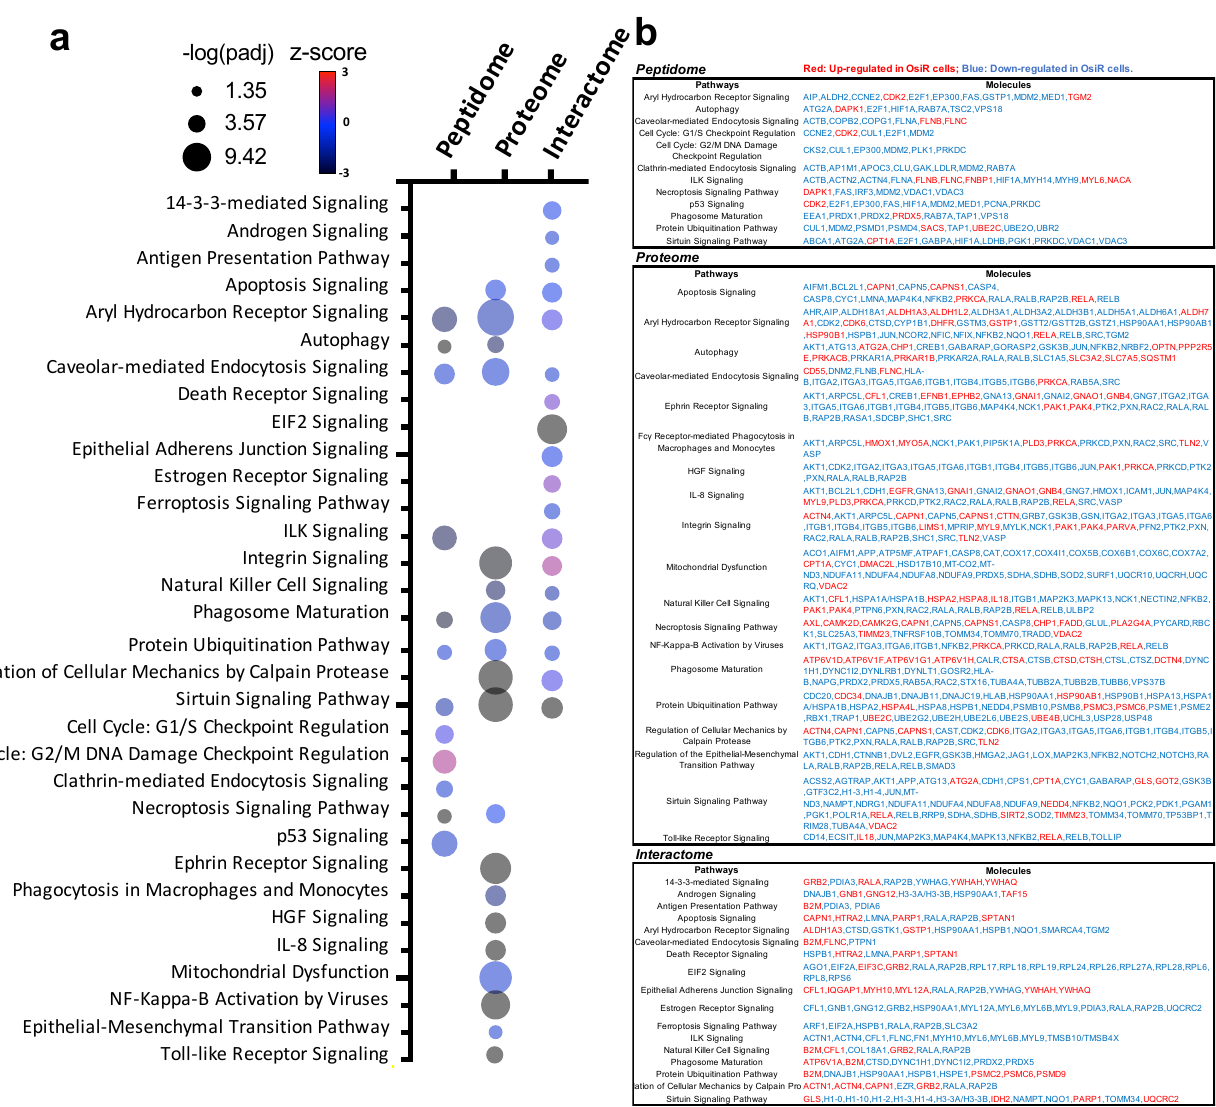
Figure 9. Intergard pathway analysis of significantly altered proteins. ( a ) Ingenuity Pathway Analysis (IPA) of sig- nificantly altered proteins (Log2 Ratio H/L > |0.6|) identified in peptidome, proteome, interactome in at least in one OsiR cell line, PC9-OsiR/PC9 and/or H1975-OsiR/H1975. Noted that only significantly enriched pathways were shown ( p -value adjusted < 0.05); positive z-score indicates activated pathways, and negative z-score indicates inhibited path- ways. ( b ) Table chart shows the gene names involved in significant enriched pathways in peptidome, proteome and interactome, respectively. Red coded genes indicate up-regulated/presented in OsiR, and blue coded genes indicate down-regulated/presented in